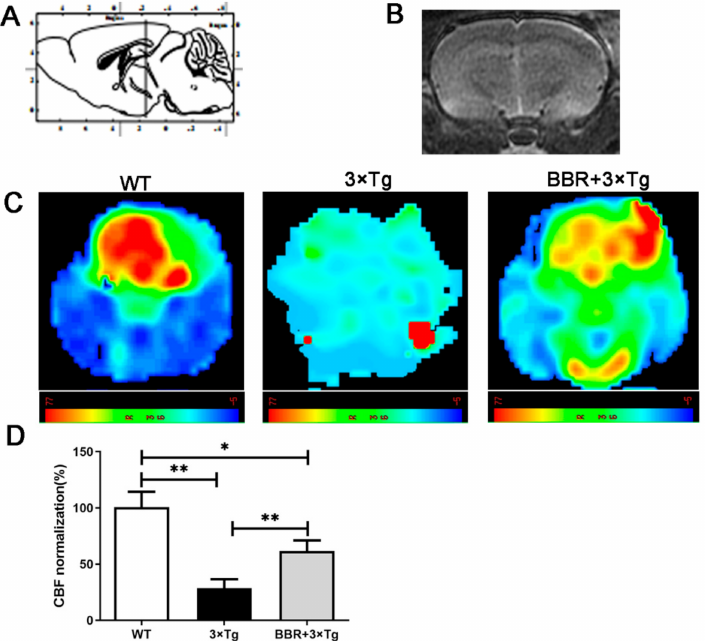
Figure 1. Magnetic resonance imaging (MRI; 3D ASL) analysis showing changes in CBF in the brain of mice. ( A ) A cross-sectional image corresponding to the brain mapping of mice. ( B ) The gray-scale images are T2 imaging. ( C ) MRI images show the changes in CBF in the brain of mice, and color images are those with 3D ASL. The red label indicates a relatively higher CBF level, while the green indicates a relatively lower CBF level. ( D ) Quantitative analysis results of CBF in mice brains. WT, wild-type mice, 3 × Tg, 3 × Tg AD mice, BBR + 3 × Tg; 3 × Tg AD mice were given BBR at 100 mg/kg/day. One-way ANOVA and Dunnett’s post-hoc test were used to analyze all the data, expressed as mean ± SD; n = 12 animals/group. * p < 0.05, ** p <